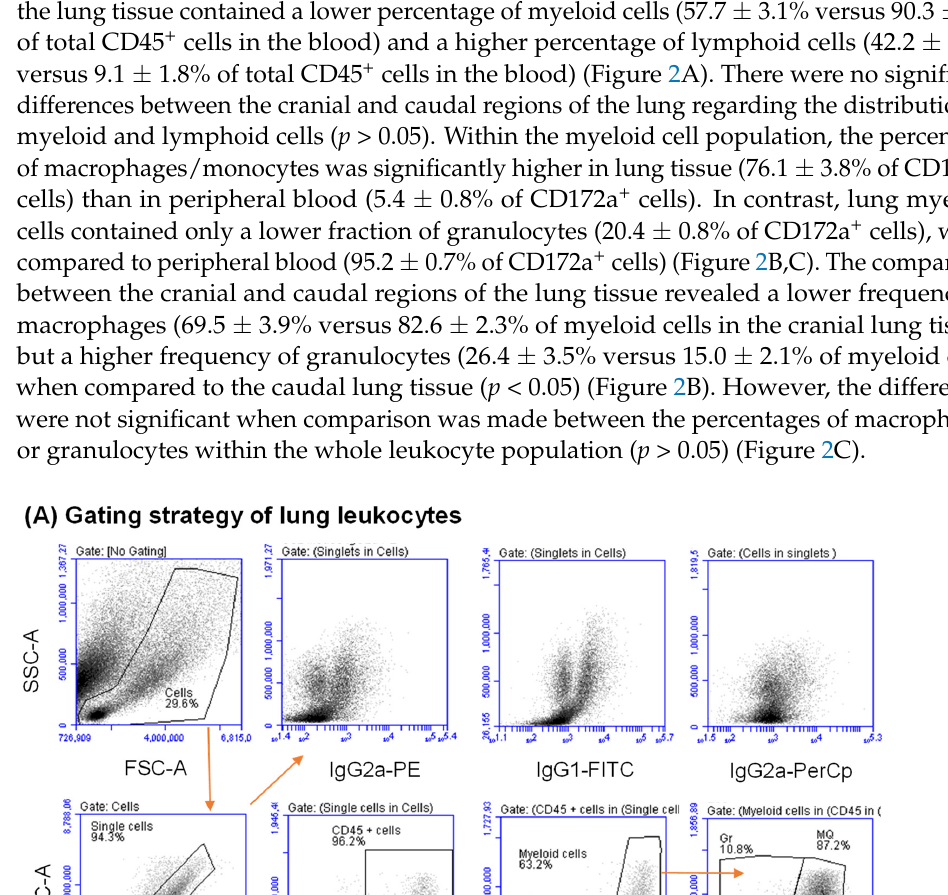
Figure 1. Flow cytometric analysis of leukocyte populations in the lung tissue and peripheral blood of dromedary camels. Lung cells ( A ) and blood leukocytes ( B ) were labeled with monoclonal anti- bodies to CD45, CD172a, and CD14 or with isotype control antibodies, and labeled cells were ana- lyzed by flow cytometry. After the exclusion of cell debris in a SSC/FSC dot plot, a gate was set on single cells in a FSC-H against FSC-A dot plot. Total lung and total blood leukocytes were identified as CD45-positive cells. Lung and blood myeloid cells were differentiated from lymphoid cells based on their expression level of the myeloid marker CD172a. Lung macrophages and blood monocytes were identified based on their higher expression of the monocytic marker CD14 (CD172a high CD14 high ), while granulocytes were identified as CD172a high CD14 low cells. In comparison to their composition in peripheral blood, the leukocyte population in the lung tissue contained a lower percentage of myeloid cells (57.7 ± 3.1% versus 90.3 ± 1.9 of total CD45 + cells in the blood) and a higher percentage of lymphoid cells (42.2 ± 3.5%